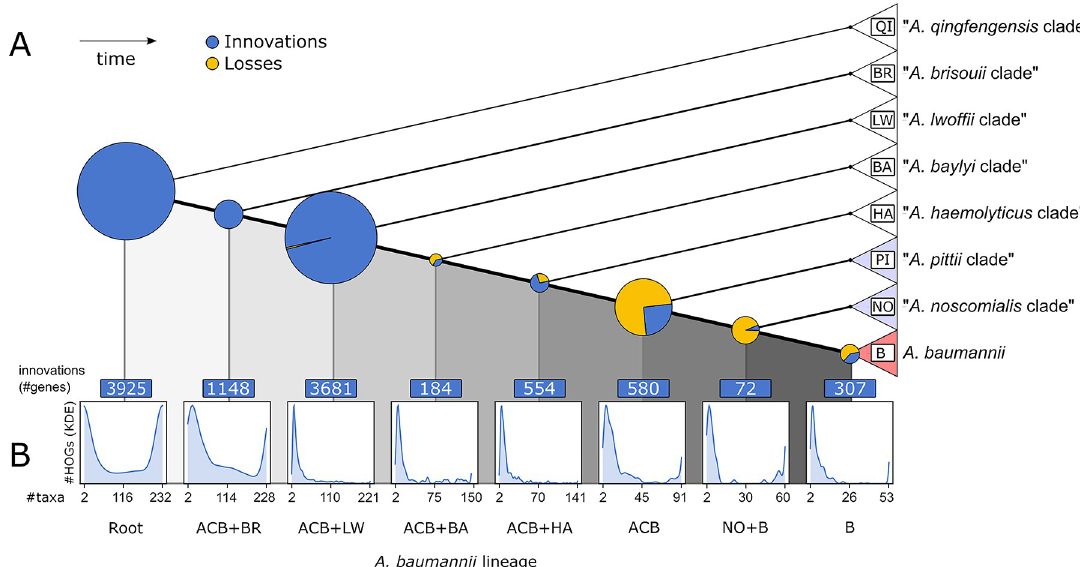
Fig 3. A phylogenetic stratification of the Acinetobacter pan-genome. (A) Pie charts on the internal nodes indicate numbers of genes added (blue) or lost (yellow) from the respective pan-genome where the diameter is proportional to the sum of both gained and lost genes. Clades resemble those from Fig 2. (B) For each node, histograms represent the number of descending taxa an added gene is represented in. The minimum value is 2, the maximum value is the number of taxa subsumed in the corresponding